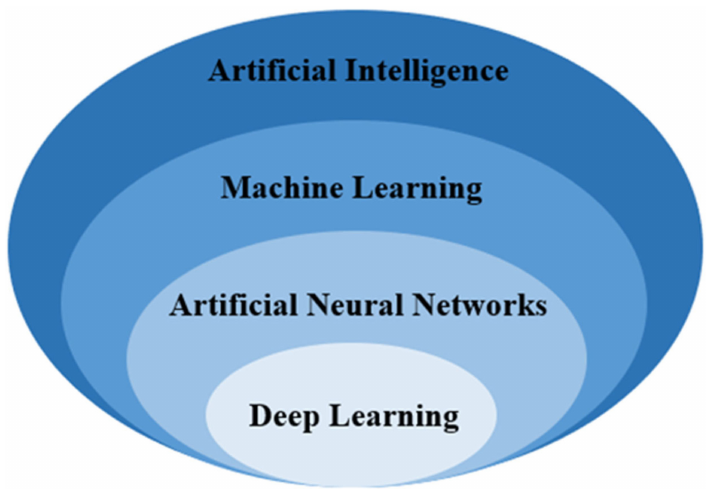
Figure 1. The relationship between artificial intelligence, machine learning, artificial neural networks, and deep